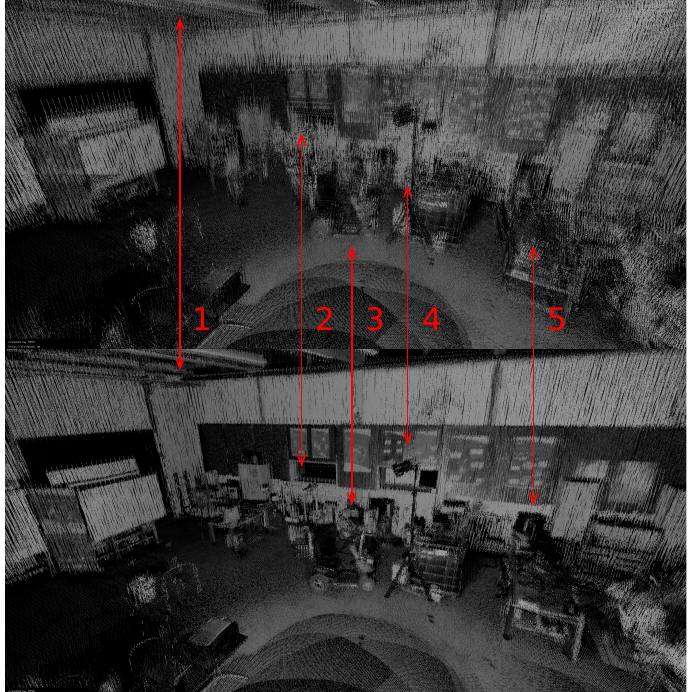
Figure 11. Details from the 3D point cloud of Experiment 2. The arrows mark some examples for the improvements by semi-rigid registration. 1: the structure of the ceiling gets clearer. 2: the edges of the windows do match. 3: the scooter appears separated from the structure behind. 4: the tripod of the lamp appearing twice converged. 5: the objects on the table are distinguishable.